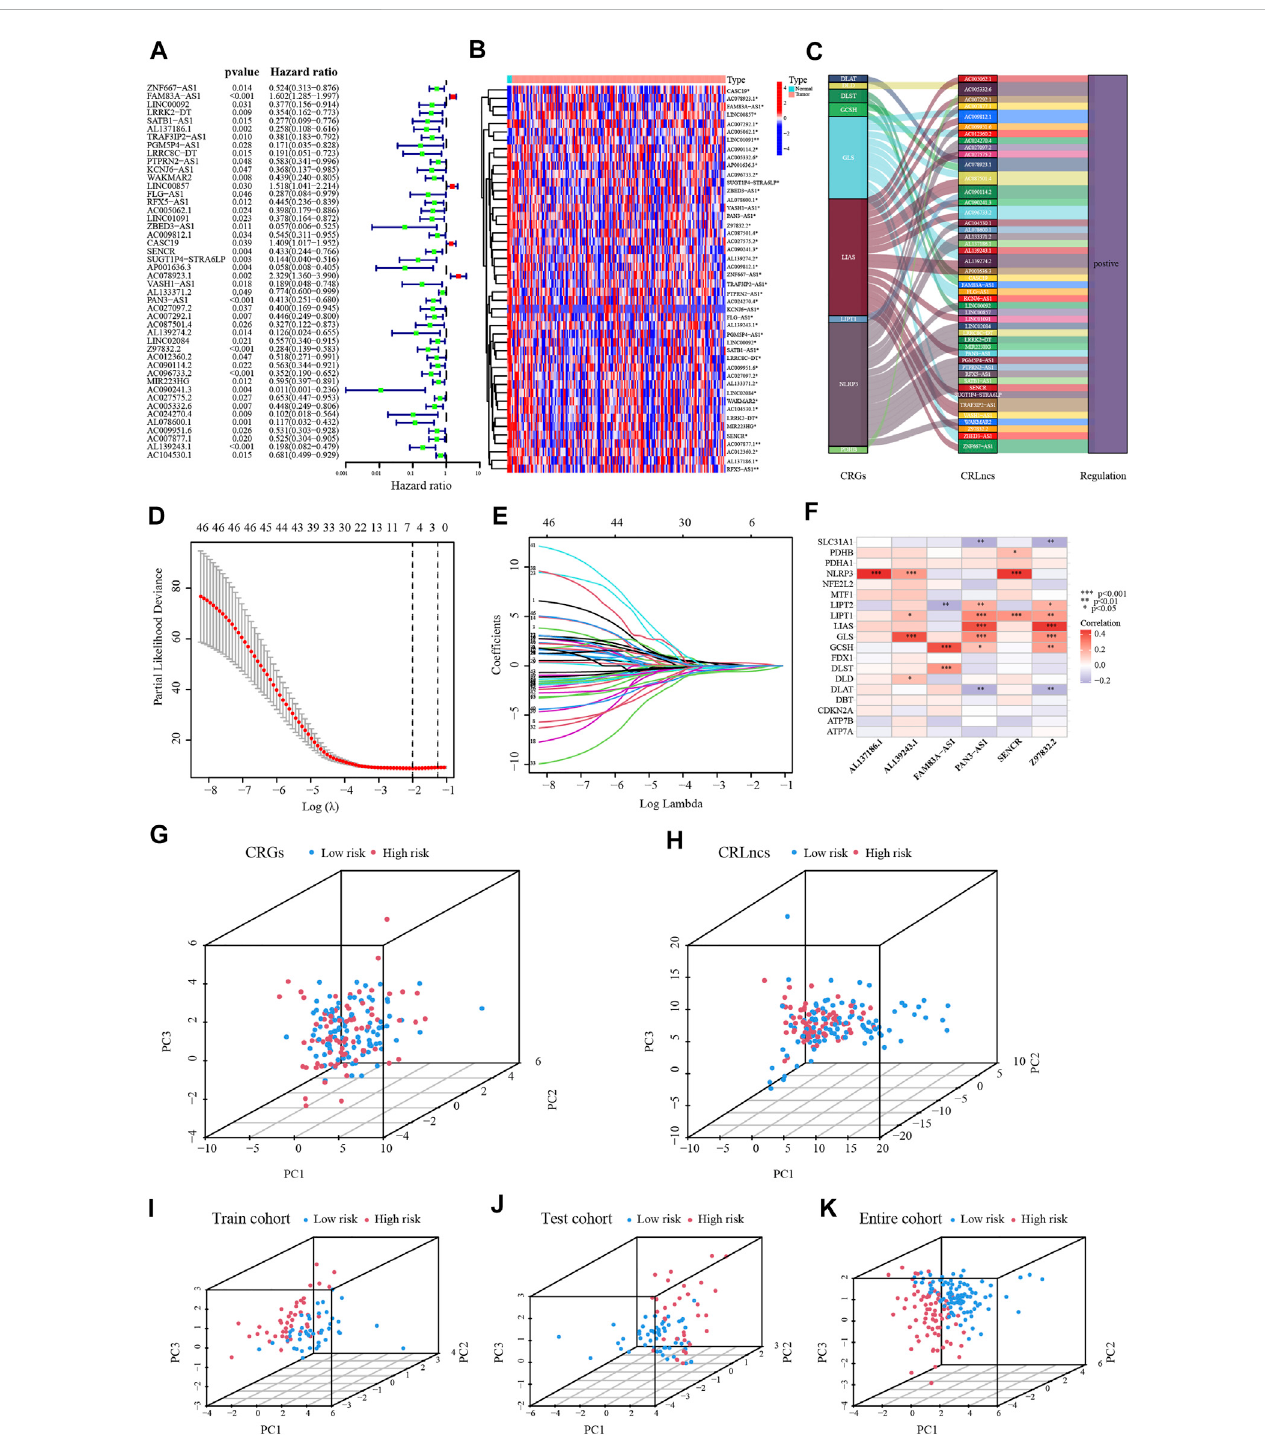
FIGURE 3 Establishment of the CRLncs signature for PC. (A) Recognition of the prognostic CRLncs in PC via univariate Cox regression analysis. (B) Heatmap of the expression of prognostic CRLncs. (C) The ggalluvial diagram of relationship between CRGs and prognostic CRLncs. (D,E) The LASSO Cox regression analysis wasperformeddependingontheoptimal λ value. (F) TherelationshipbetweenCRGswithsignatureCRLncs. (G – K) ThePCAofPCpatientsintheTCGA-train, test, and entire cohort. * p < .05, ** p < .01; *** p < .001; ns, not signi fi